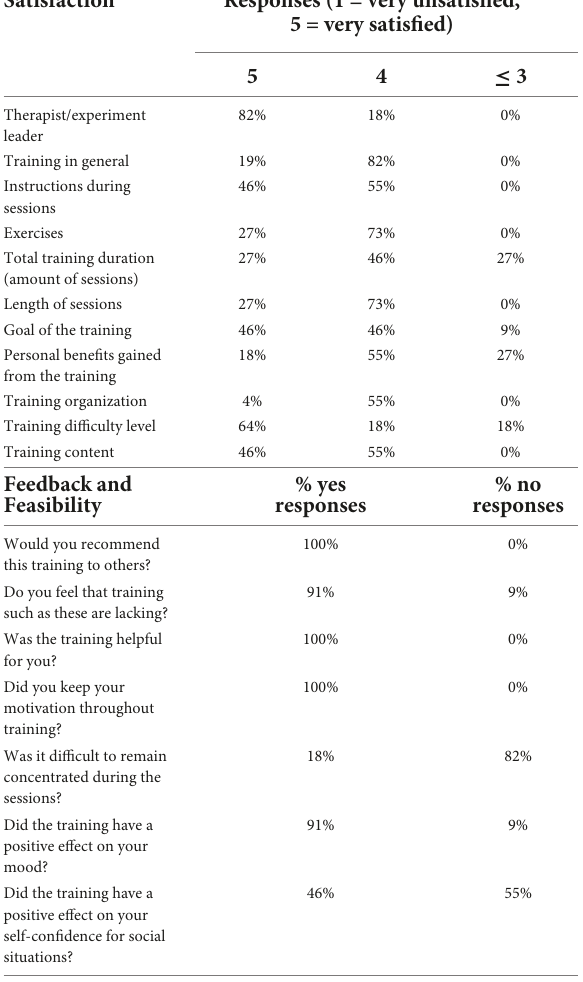
TABLE 4 Feedback and satisfaction questionnaire